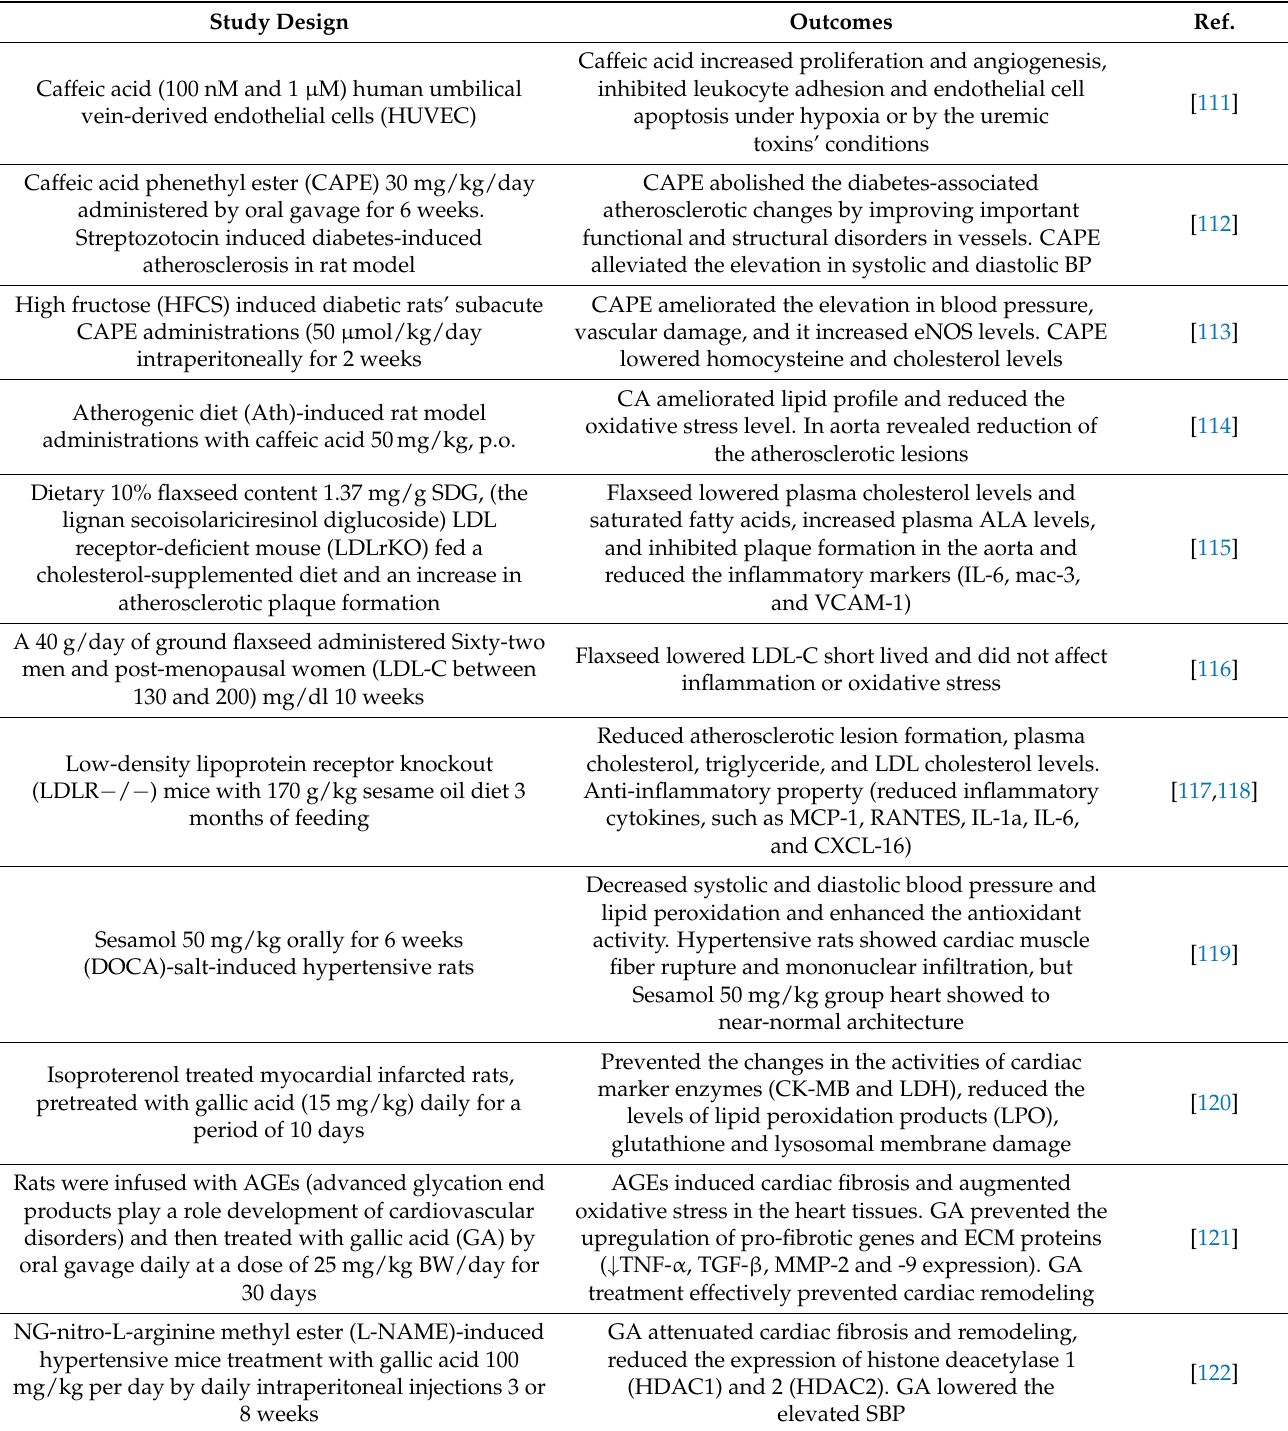
Table 2. Some of the polyphenol efficacies, working concentration, and target of each substance on cardiovascular